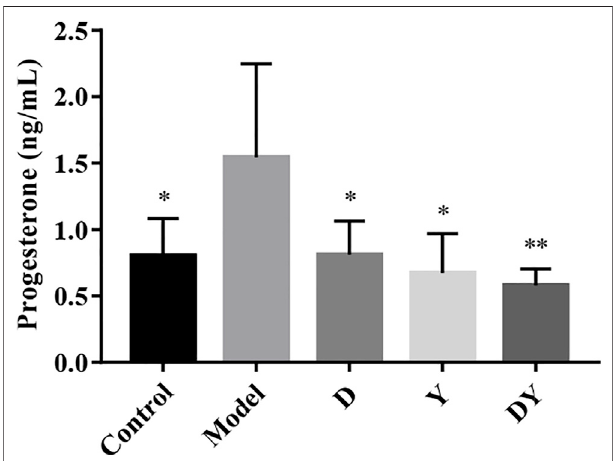
FIGURE1| Theserumprogesteronelevelsofabortionmicetreatedwith D, Y, and DY was measured. The data were presented as mean ± SD. (** p < 0.01 and * p < 0.05, vs. Model group).